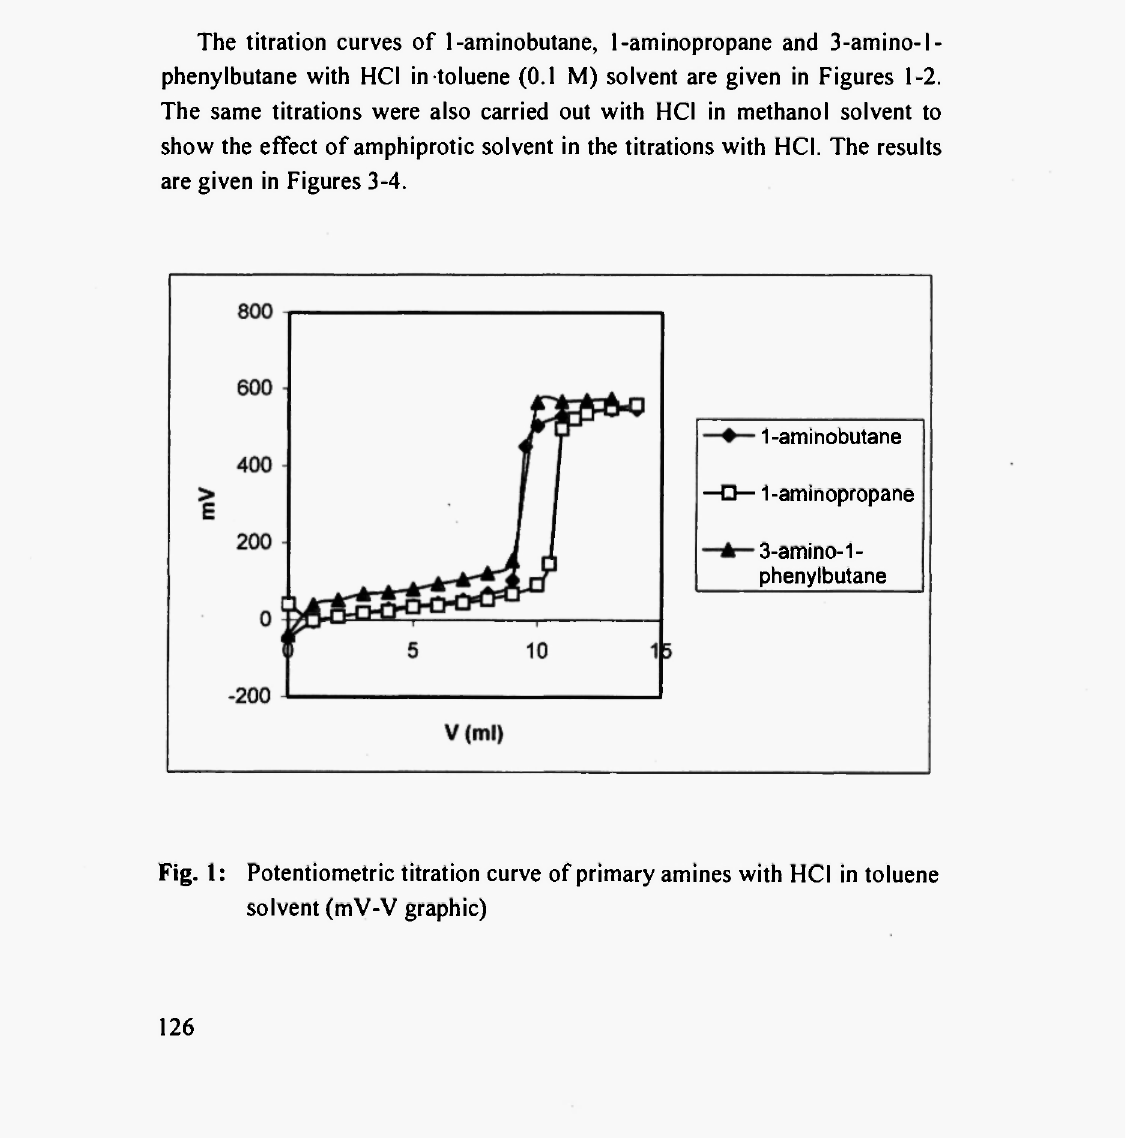
Fig. 1: Potentiometrie titration curve of primary amines with HCl in